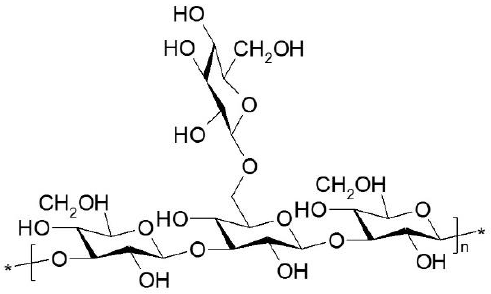
Figure 1. Bioactivity of polysaccharides and triterpenoids from Ganoderma lucidum .